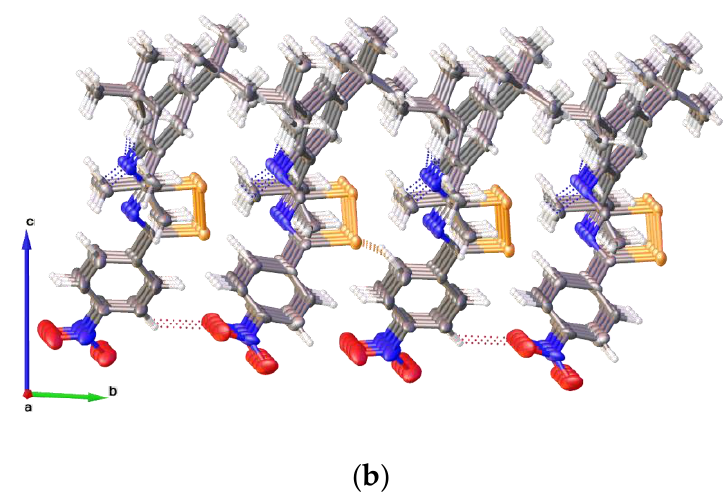
Figure 4. ( a ): intramolecular interactions seen in 3 ; ( b ): supramolecular structure in 3 . Atoms colors are the same as in Figure 3 except hydrogen, which is